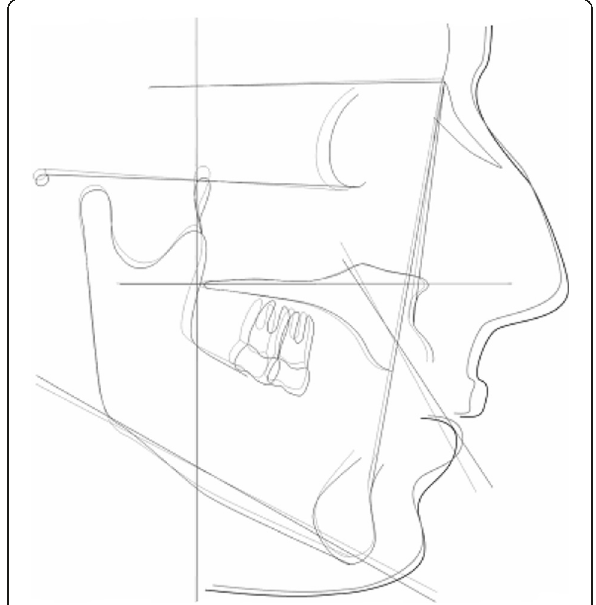
Fig. 5 Superimposition of one of the patients treated in this